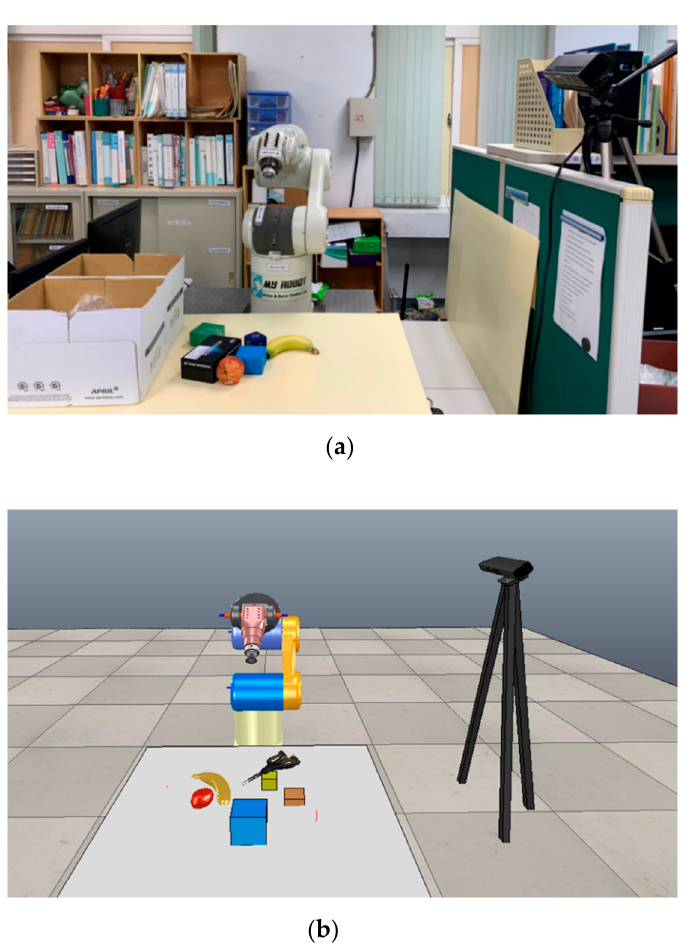
Figure 8. Experimental and simulated environment: ( a ) real experimental environment; ( b ) simu- lated environment.